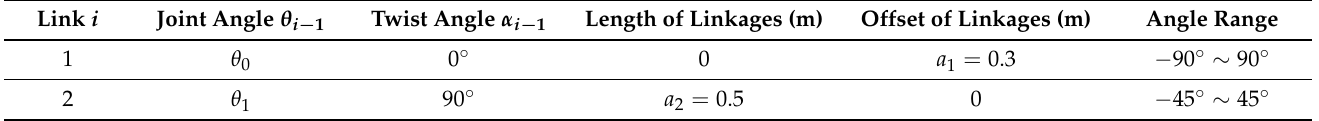
Figure 5. Dimensions, motion range, and start–target configurations of a two-DOF manipulator. Table 1. D-H parameters of a two-DOF